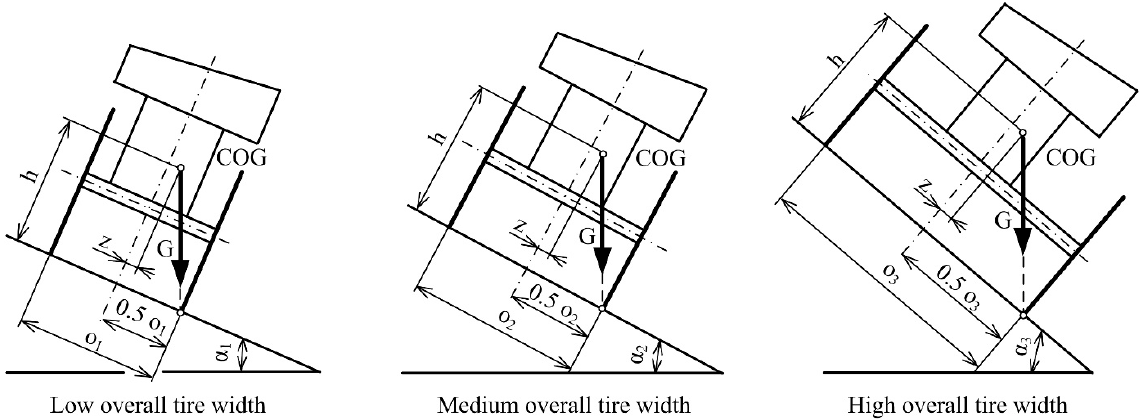
Figure 3. Influence of the overall tire width on tractor stability: o —overall tire width; z —lateral position of COG; α —static overturning angle; h —vertical coordinate of COG.